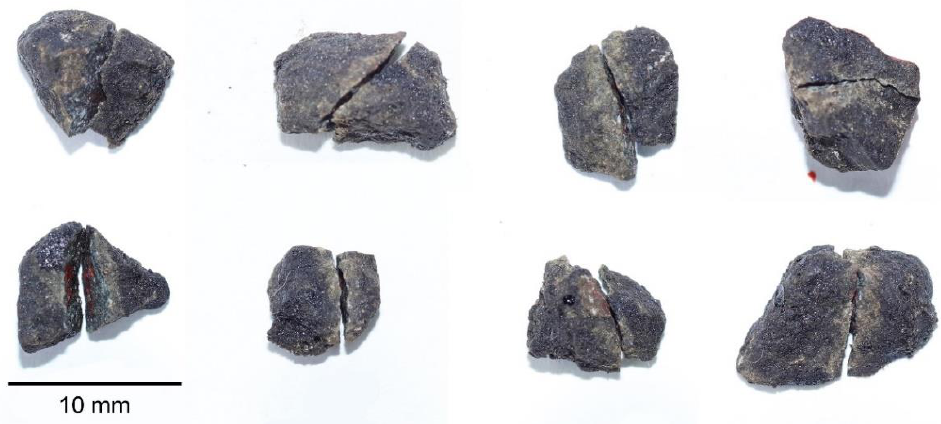
Figure 16 . Fracture propagation by the crack path: ( a ) through an aggregate particle and ( b ) around an aggregate particle.